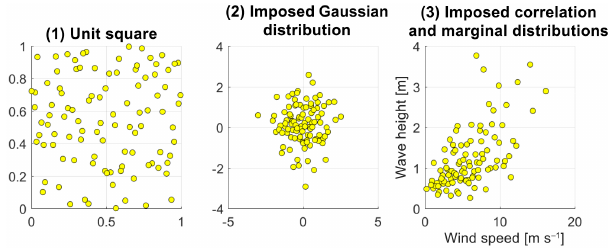
Figure 4. Exemplary definition of environmental sample points based on 100